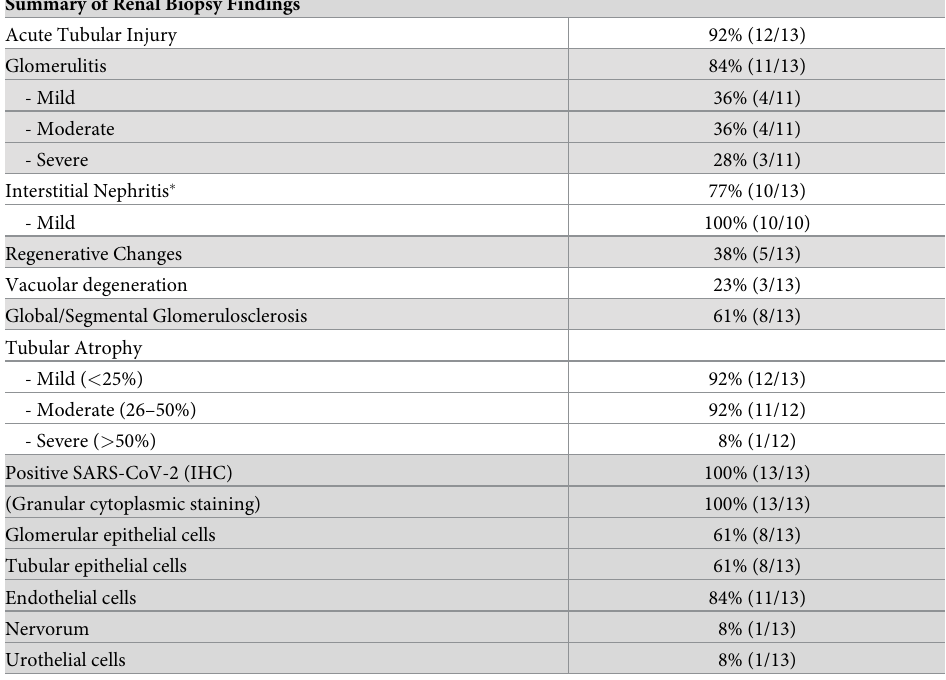
Table 5. Renal biopsy